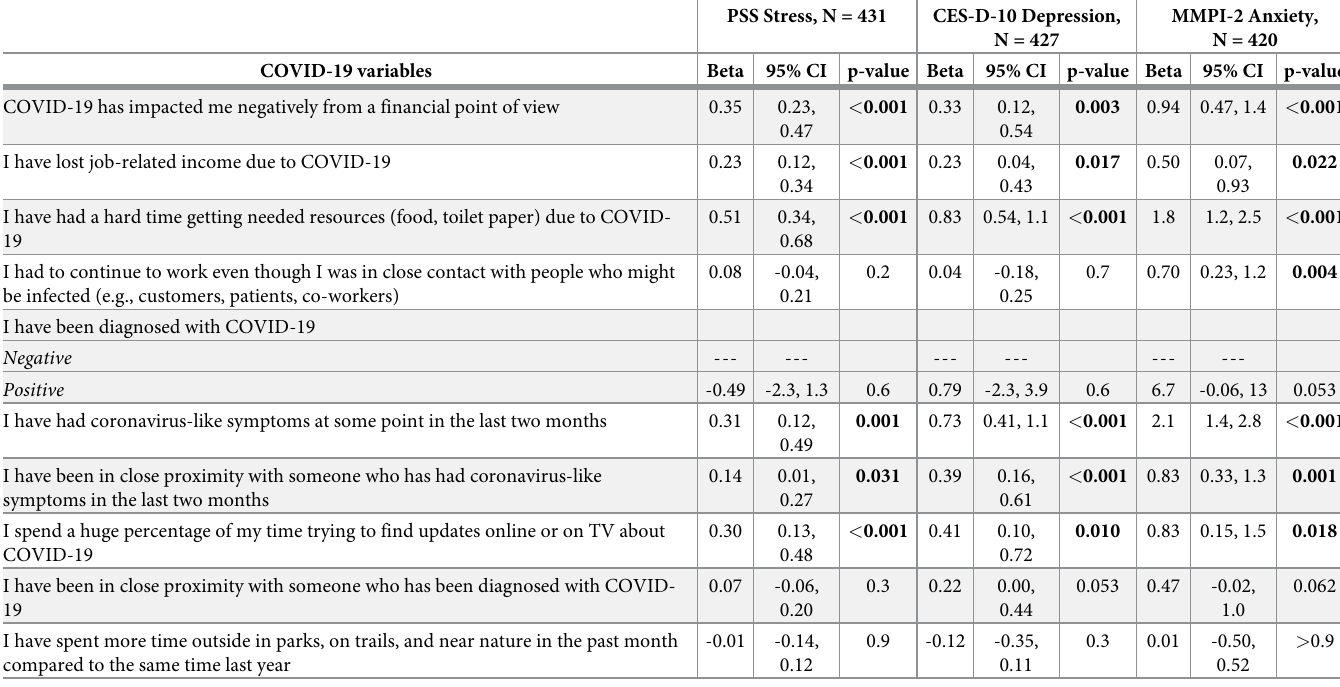
Table 2. Univariate regression of measures of psychological stress and distress and COVID-19